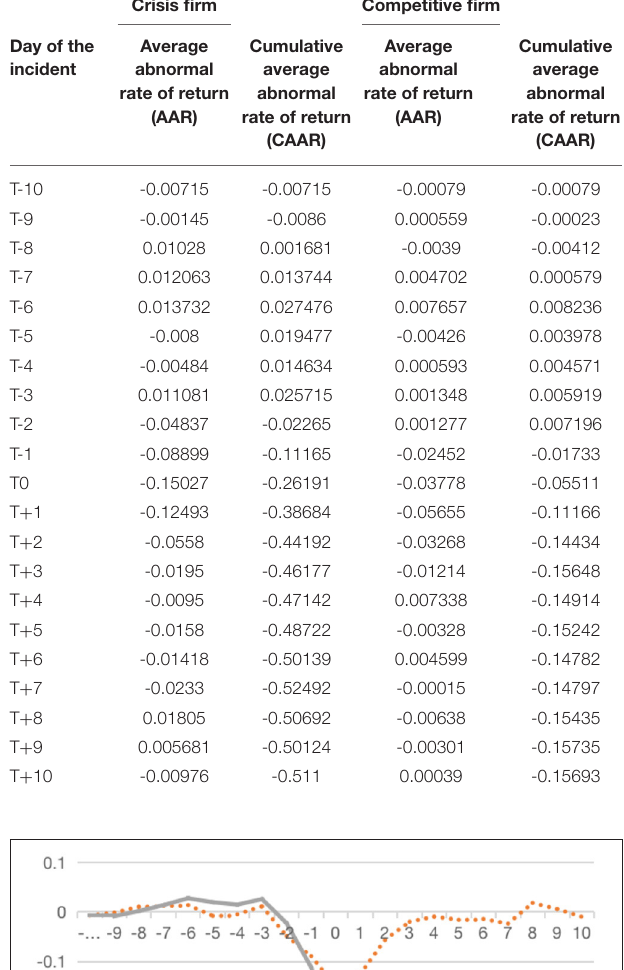
TABLE 2 | AAR and CAAR of two types of sample firms during the incident period.